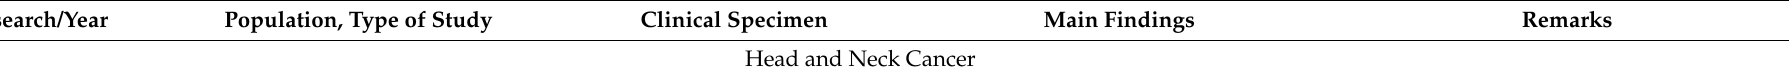
Table 1. List of main studies associating the mycobiome with various types of neoplasms in animal models and